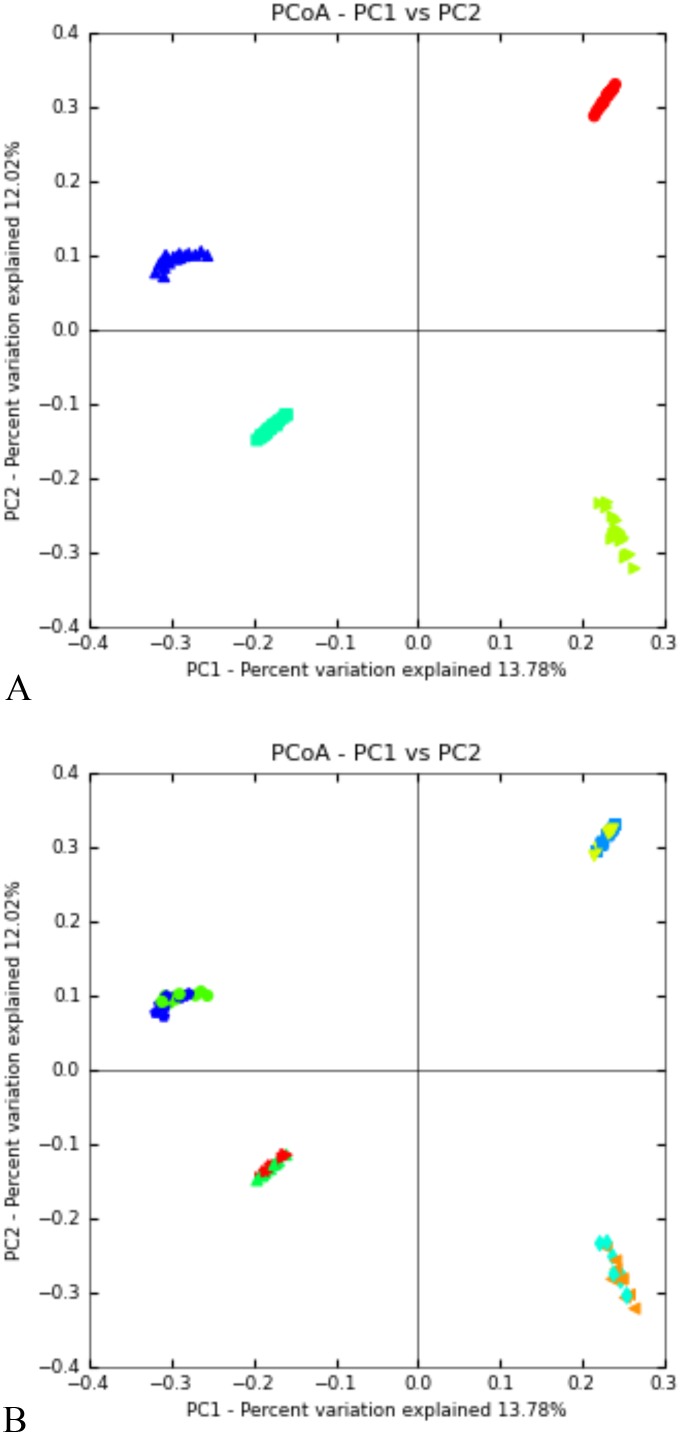
Principal coordinate analysis (PCoA) of lamb rumen bacterial samples by sampling time (A) and treatment (B).Sampling time (A) is week 2 = teal, week 6 = green, week 11 = red, and week 23 = dark blue for both groups. Treatment (B) is control (con) week 2 = red, experimental (exp) week 2 = green triangle, con week 6 = orange, exp week 6 = teal, con week 11 = yellow, exp week 11 = blue, con week 23 = green, exp week 4 = dark blue.